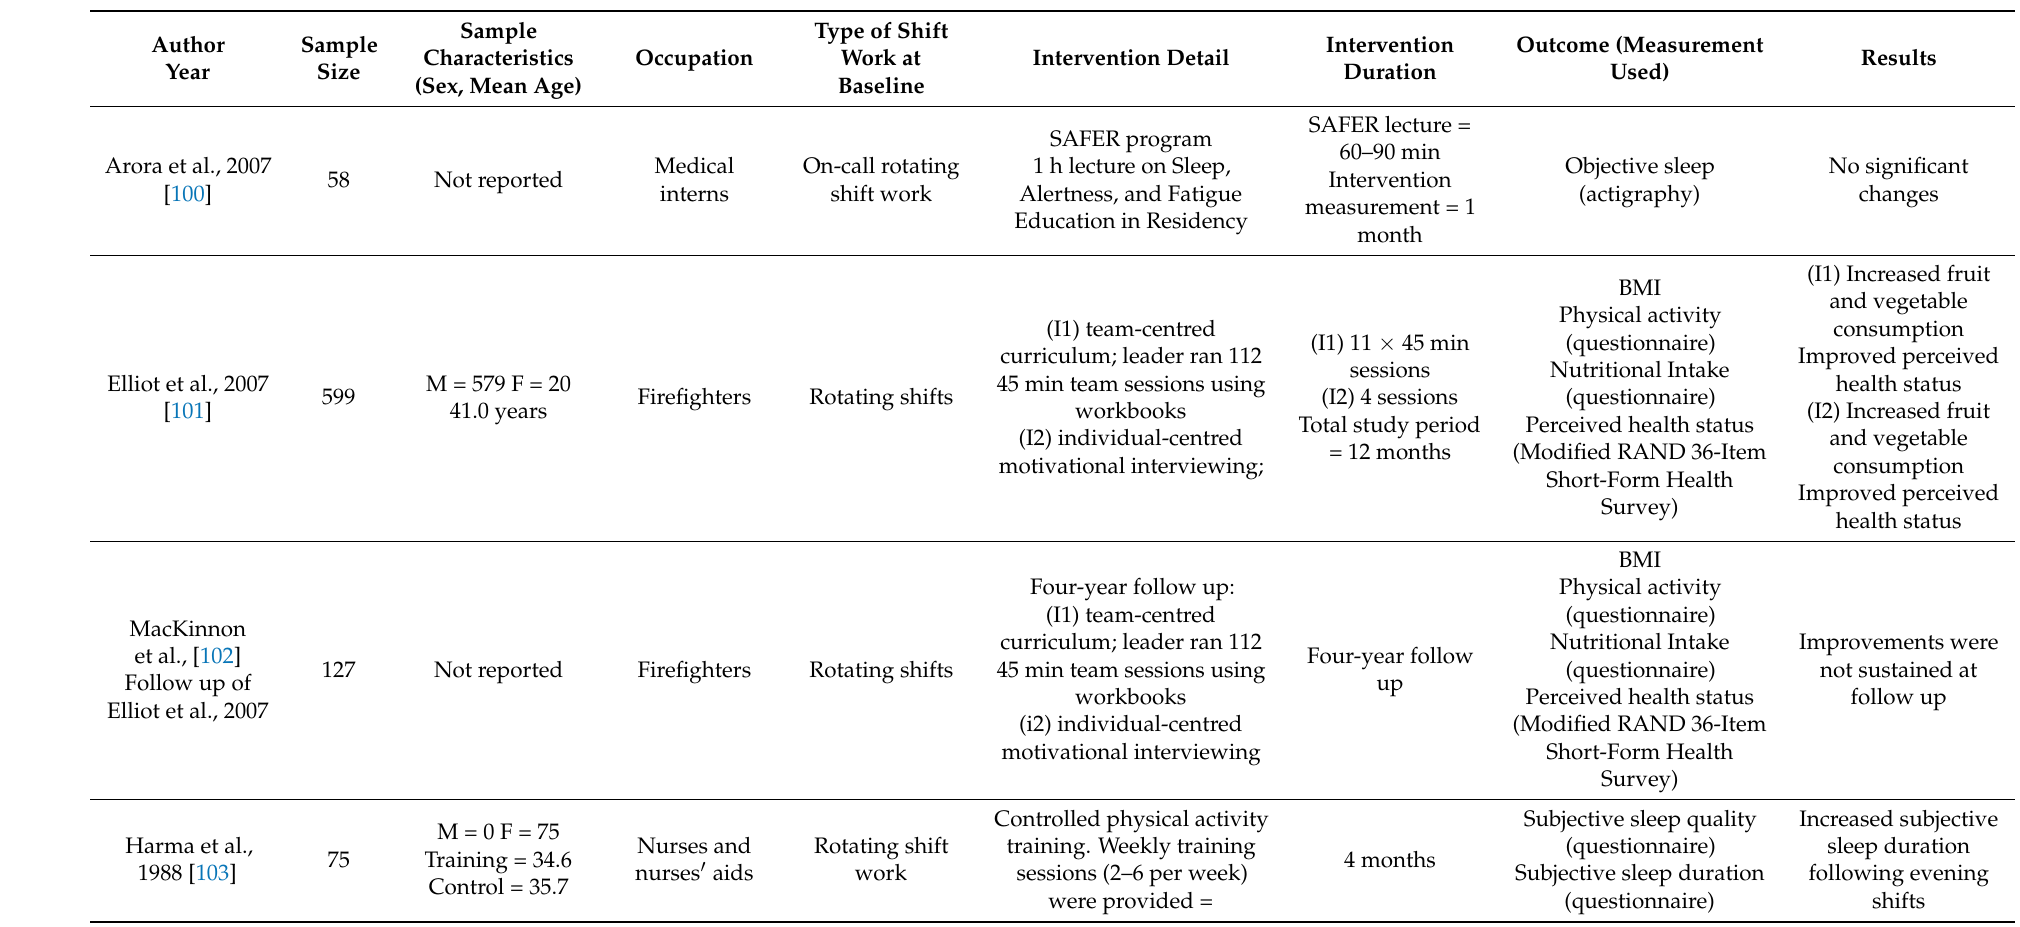
Table 4. Studies investigating behavioural